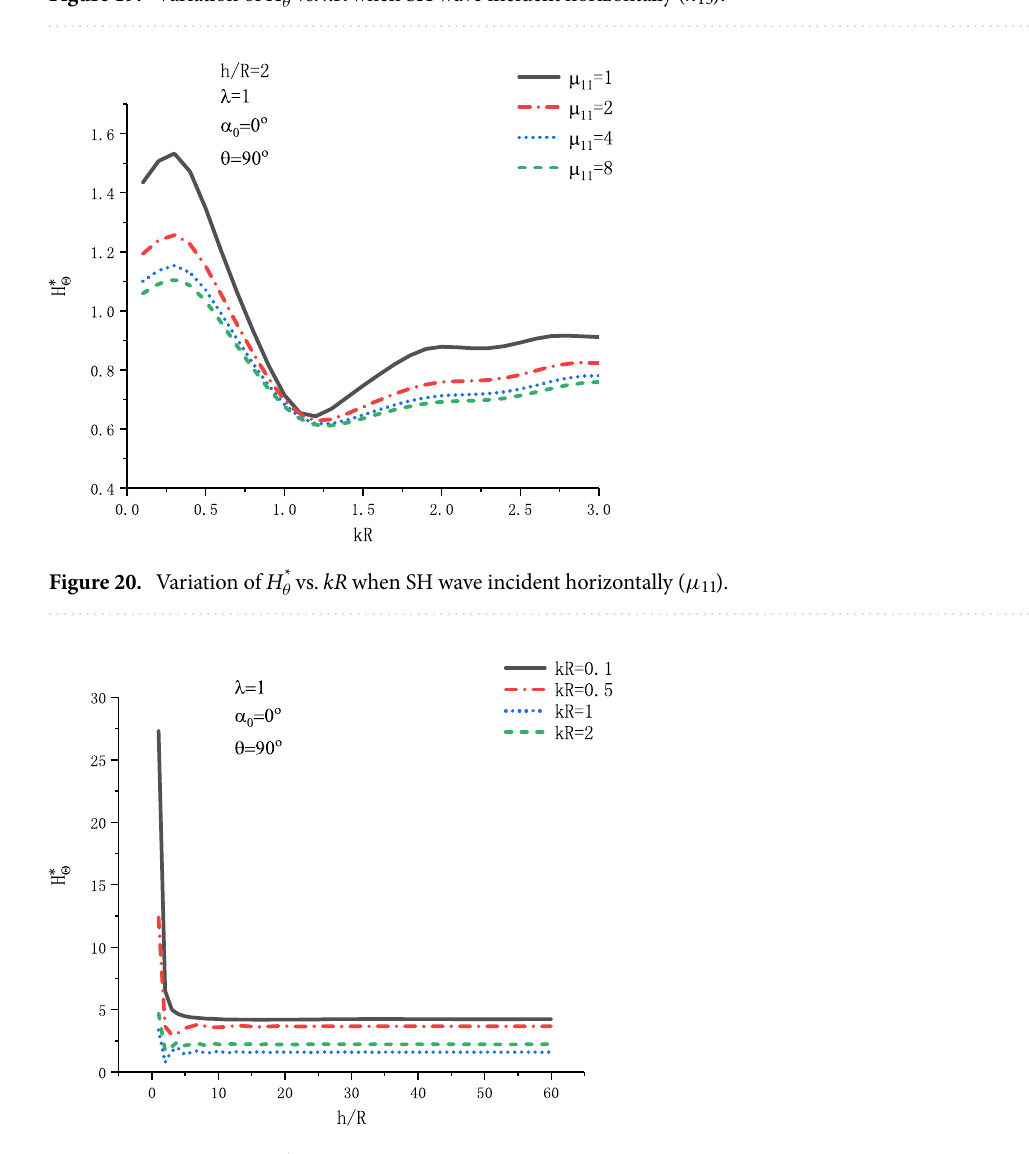
Figure 19. Variation of H